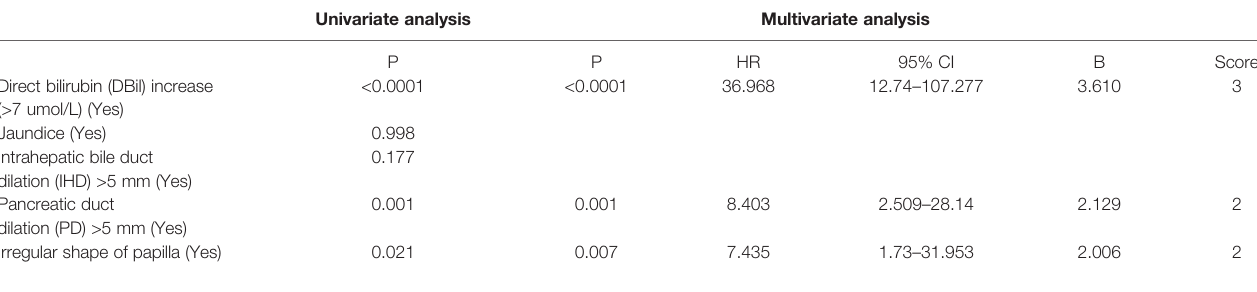
TABLE 3 | Establishment of the scoring